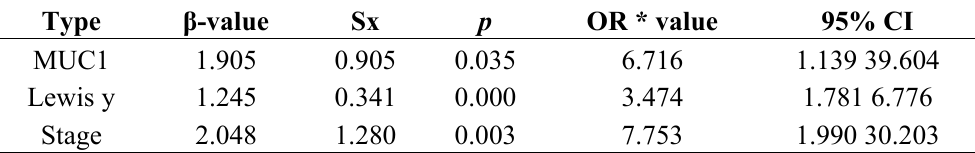
Table 3. Multivariate analysis of factors associated with